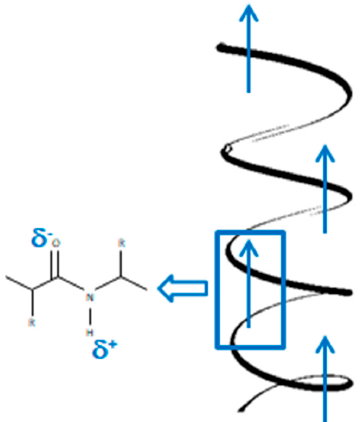
Figure 6. Scheme of permanent polarization in the α -helix.